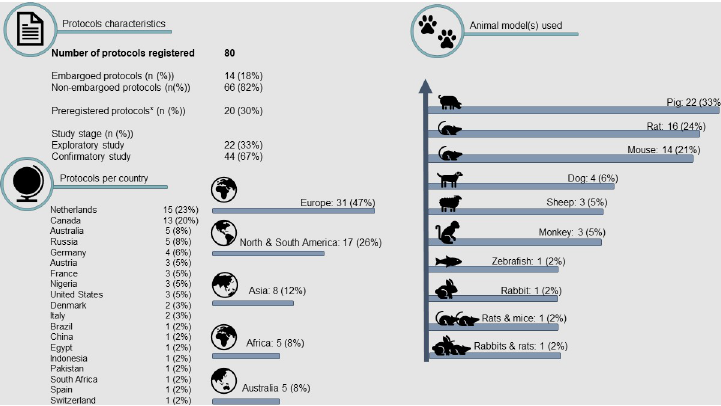
Fig 2. Protocols published on preclinicaltrials.eu on July 26, 2021. Note that only details of non-embargoed protocols are shown. � Preregistration is based on the reported study status at the first version of the submitted